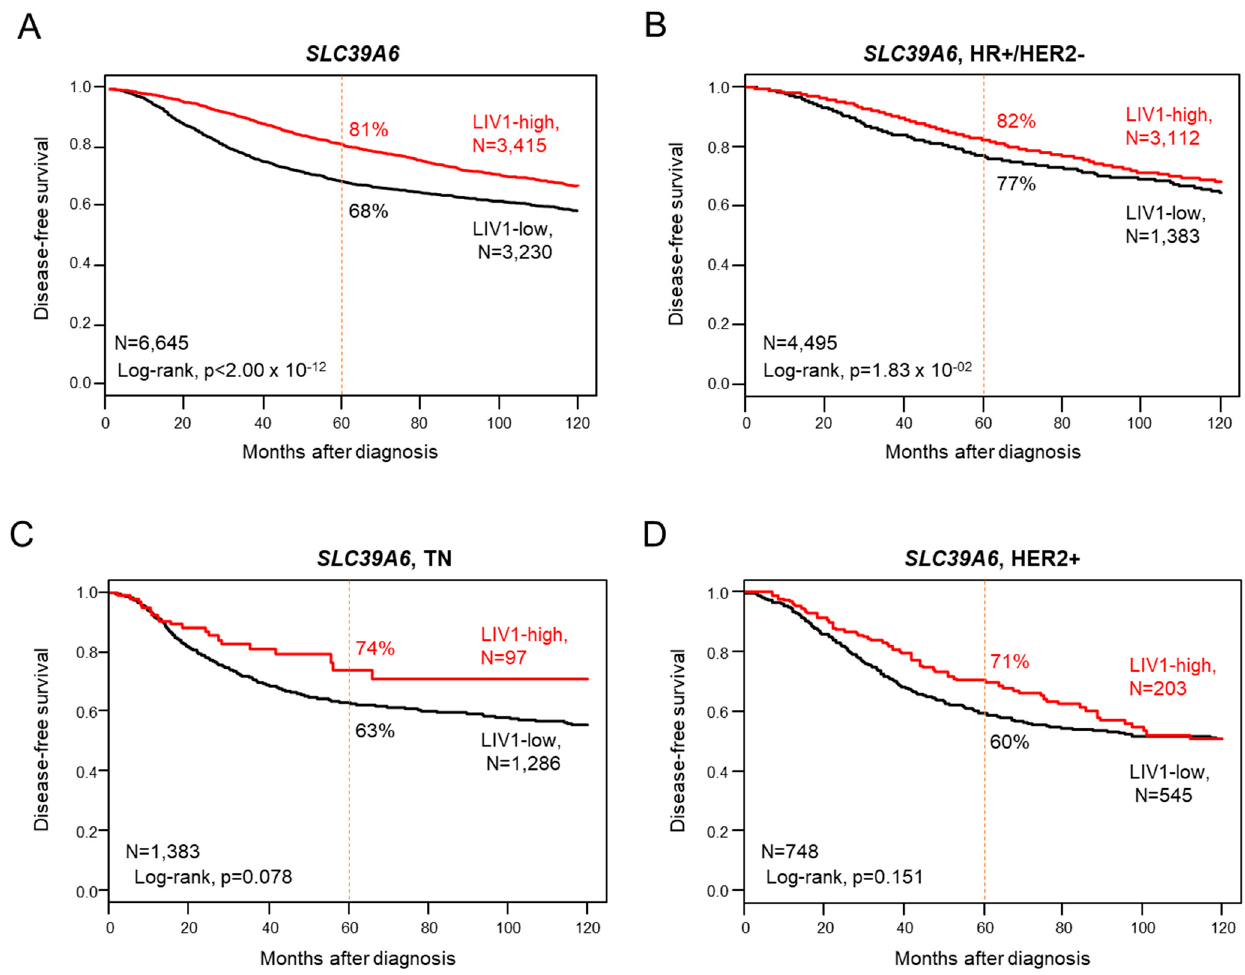
Figure 1. Prognostic value of LIV1 expression for DFS in breast cancer. Kaplan–Meier DFS curve according to high and low LIV1 mRNA expression in the whole population ( A ), in the HR+/HER2- patients ( B ), in the TN patients ( C ), and in the HER2+ patients ( D ). The corresponding Hazard Ratio for a DFS event was 0.67 (95%CI 0.61–0.73). In uni- variate analysis (Table 2), patient’s age above 50 years was associated with longer DFS ( p = 2.91 × 10 − 04 , Wald test), whereas pathological grade 2–3 ( p = 5.24 × 10 − 14 ), positive axillary